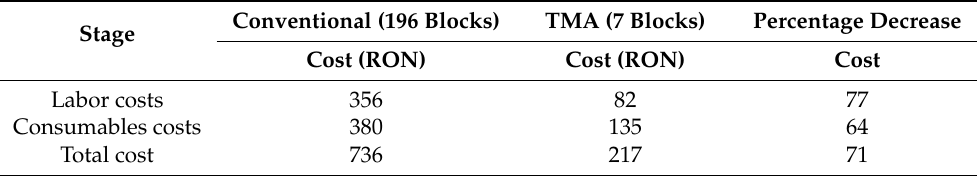
Figure 5. Testes “donor” paraffin blocks: Protocol 1–Protocol 4. White arrow: depression of the tis- sue samples within the paraffin block, a clear sign of excessive residual water/insufficient tissue processing.